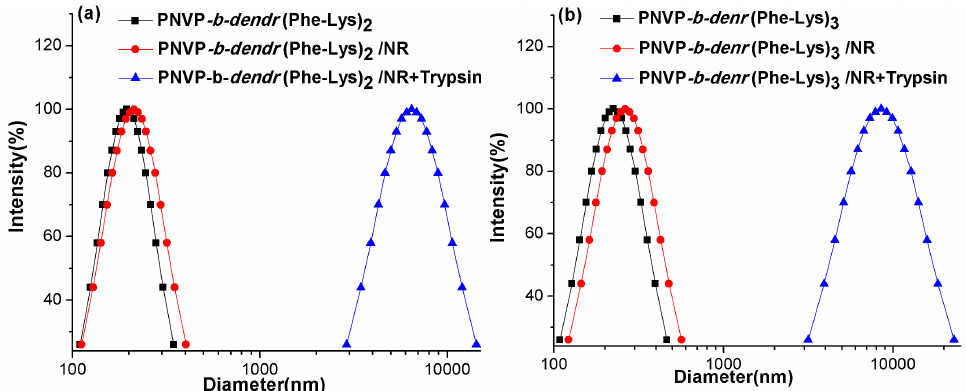
Figure 3. The particle size in PNVP -b-dendr (Phe-Lys) 2 ( a ) and PNVP -b-dendr (Phe-Lys) 3 ( b ) before and after Nile red was loaded, and the particle size of the micelle solution after the incubation with trypsin.